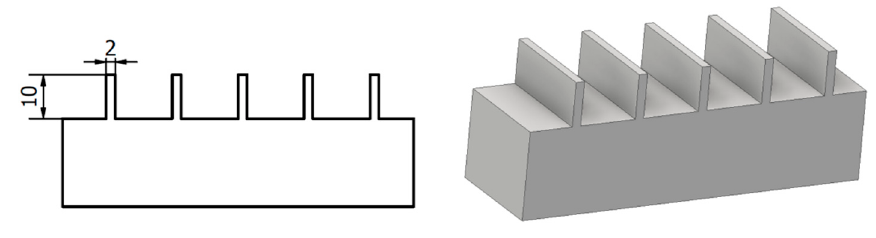
Figure 1. Research sample containing thin walls.